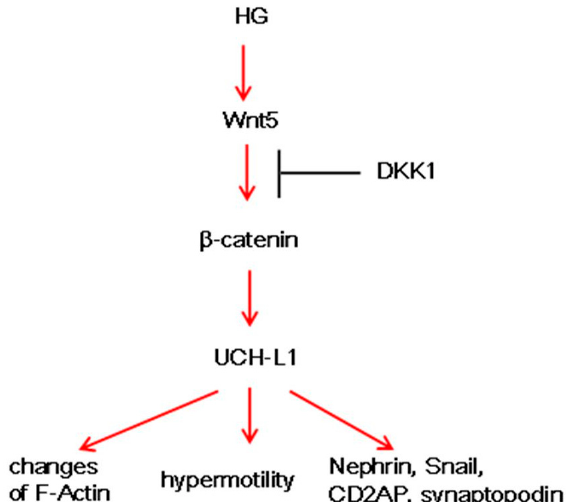
Figure 8. Diagram shows the Wnt/ β -catenin/UCH-L1 signaling leading to podocyte injury in HG environment. HG induces Wnt5, activates β -catenin, and elevates UCH-L1, followed by changes of F-actin, hypermotility and changes of some proteins, which can be blocked by DKK1.